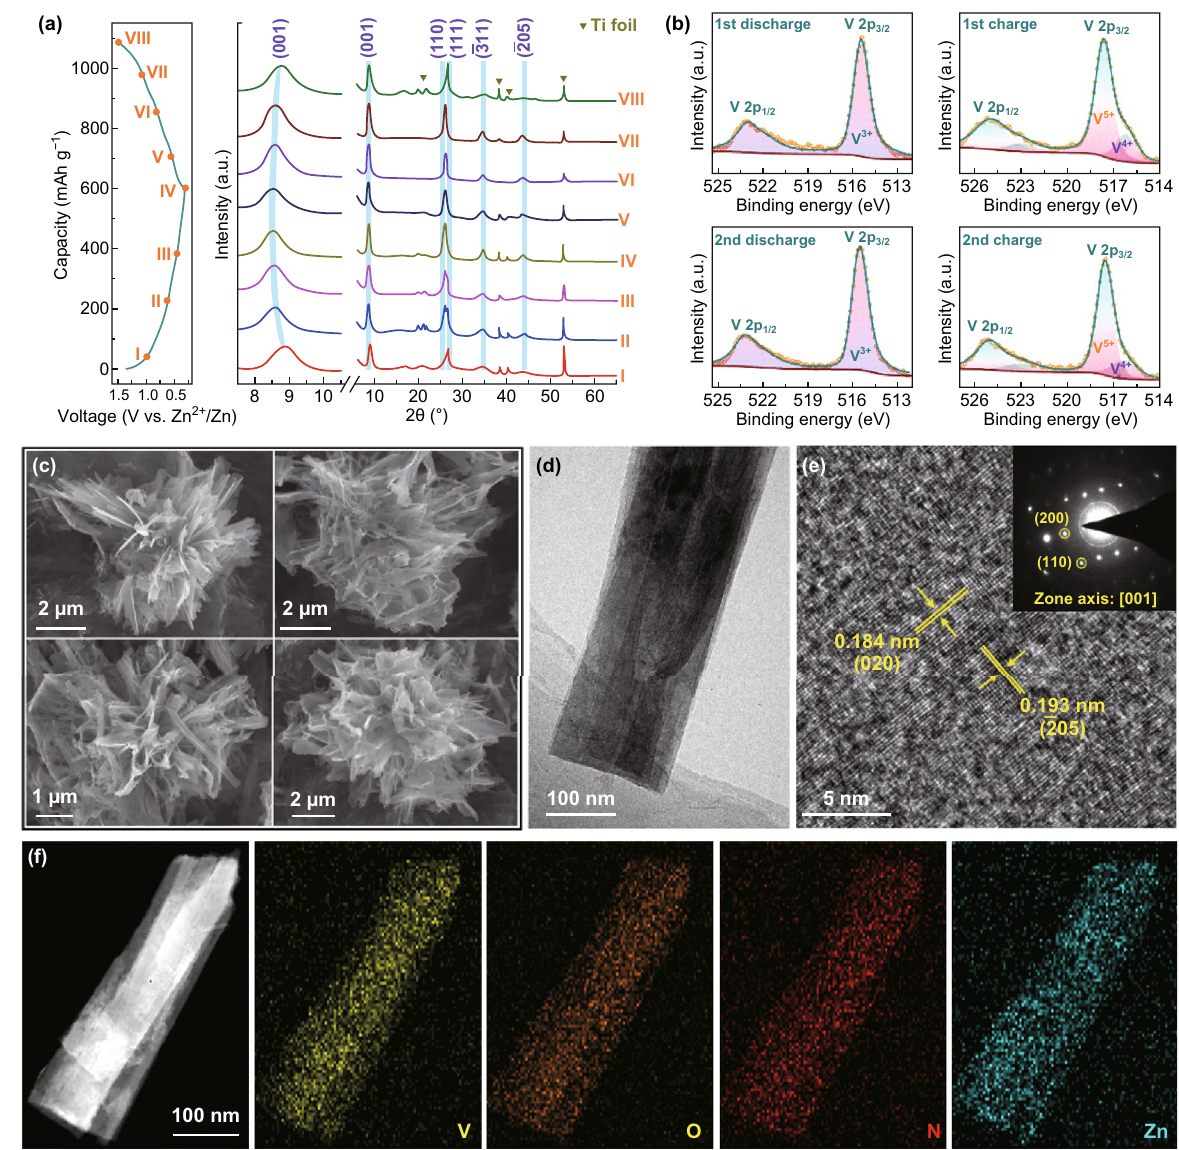
Fig. 4 Postmortem analysis of the 3D‑NVO cathode. a Ex situ XRD patterns during the first cycle. b High‑resolution XPS spectra of the V 2p region at fully discharged and charged states during the first two cycles. c SEM, d TEM, e HRTEM (inset: SAED pattern), and f STEM and the corresponding elemental mapping images of the cathode after 50 cycles at 100 mA g